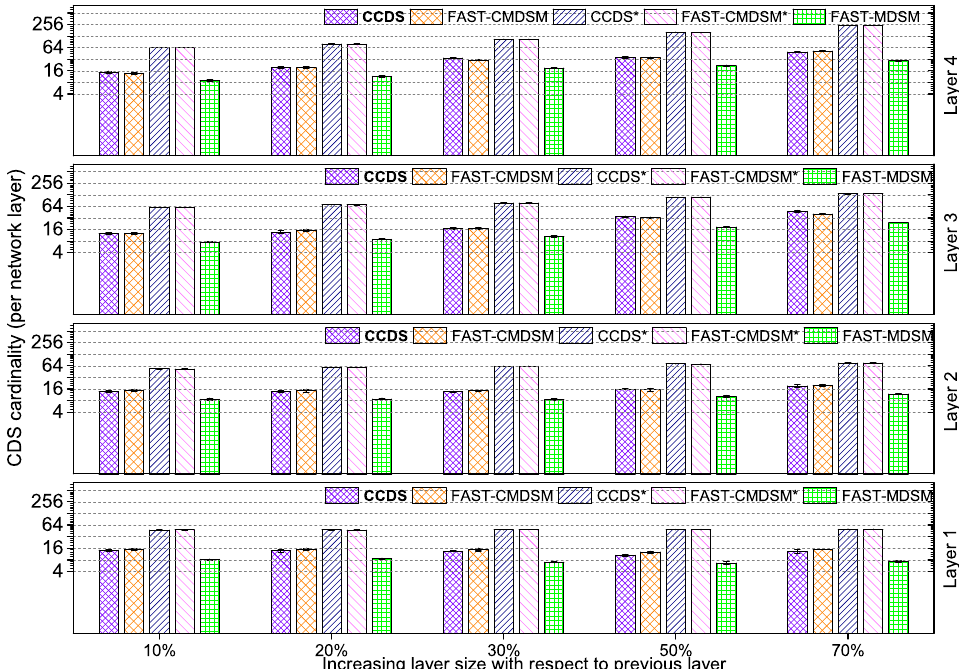
Figure 16. Impact of increasing layer cardinality (High